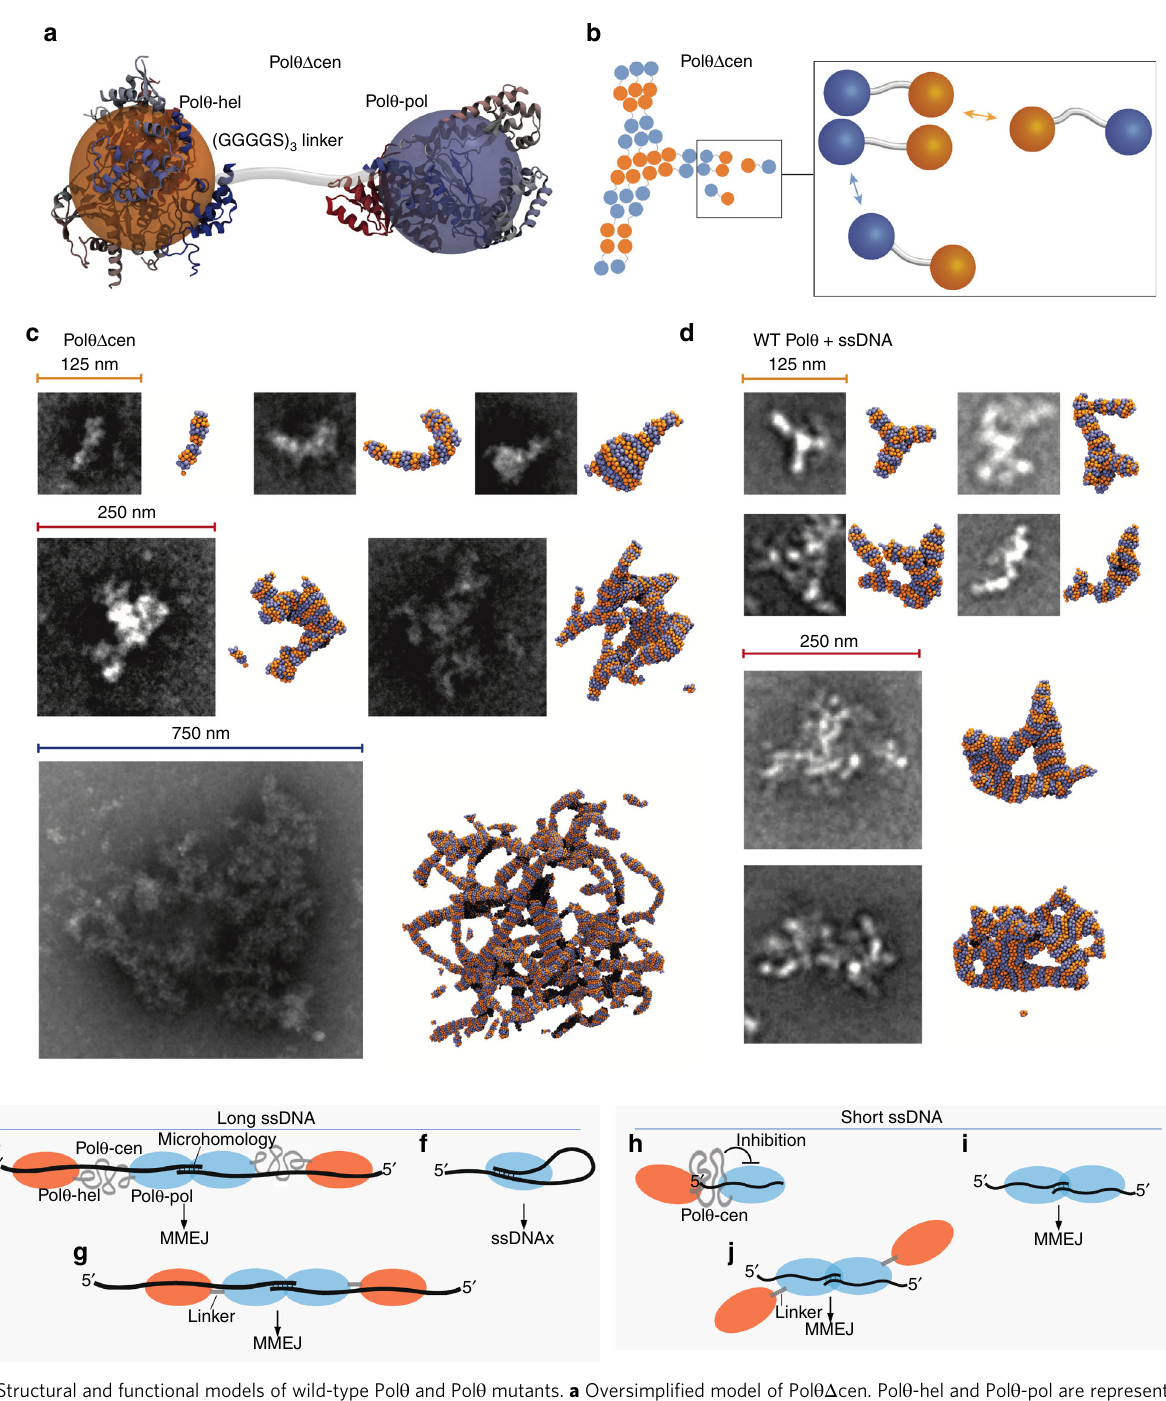
Fig. 7 Structural and functional models of wild-type Pol θ and Pol θ mutants. a Oversimpli fi ed model of Pol θΔ cen. Pol θ -hel and Pol θ -pol are represented by two spheres of radius 2.8 nm (the gyration radius of each domain). These spheres are linked by 6 beads of 1 nm in diameter, representing the (GGGGS) 3 linker. b Typical cluster formation scheme. Pol θ -hel is attracted to Pol θ -hel (orange with orange), and Pol θ -pol to Pol θ -pol (blue with blue), while all other bead interactions are repulsive. The Pol θΔ cen monomers multimerize forming parallel complexes that stack upon each other, see also Supplementary Movies 5 and 6. c , d EM images of multimeric Pol θΔ cen ( c ) and Pol θ + ssDNA ( d ) gel-like complexes at different scales alongside complexes of similar shapes obtained from simulations. The simulated molecular structures and EM images are shown using the same magni fi cation. e Model of Pol θ activity on long ( ≥ 70 nt) ssDNA. Pol θ -hel promotes Pol θ -pol MMEJ in cis in an ATPase independent manner. f Pol θ -pol primarily promotes ssDNAx via snap-back replication on relatively long ssDNA due to the absence of helicase attachment. g Pol θΔ cen exhibits identical MMEJ activity to Pol θ on long ( ≥ 70 nt) ssDNA. h Pol θ -cen suppresses Pol θ activity on short ssDNA. i Pol θ -pol promotes MMEJ of short ( ≤ 12 nt) ssDNA. j Pol θΔ cen promotes MMEJ on short ( ≤ 12 nt) ssDNA like Pol θ